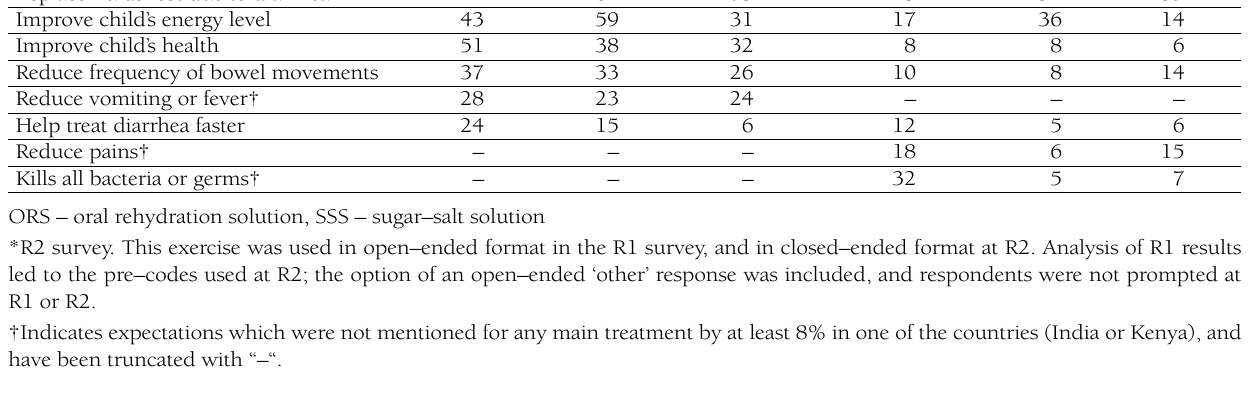
Improve child’s energy